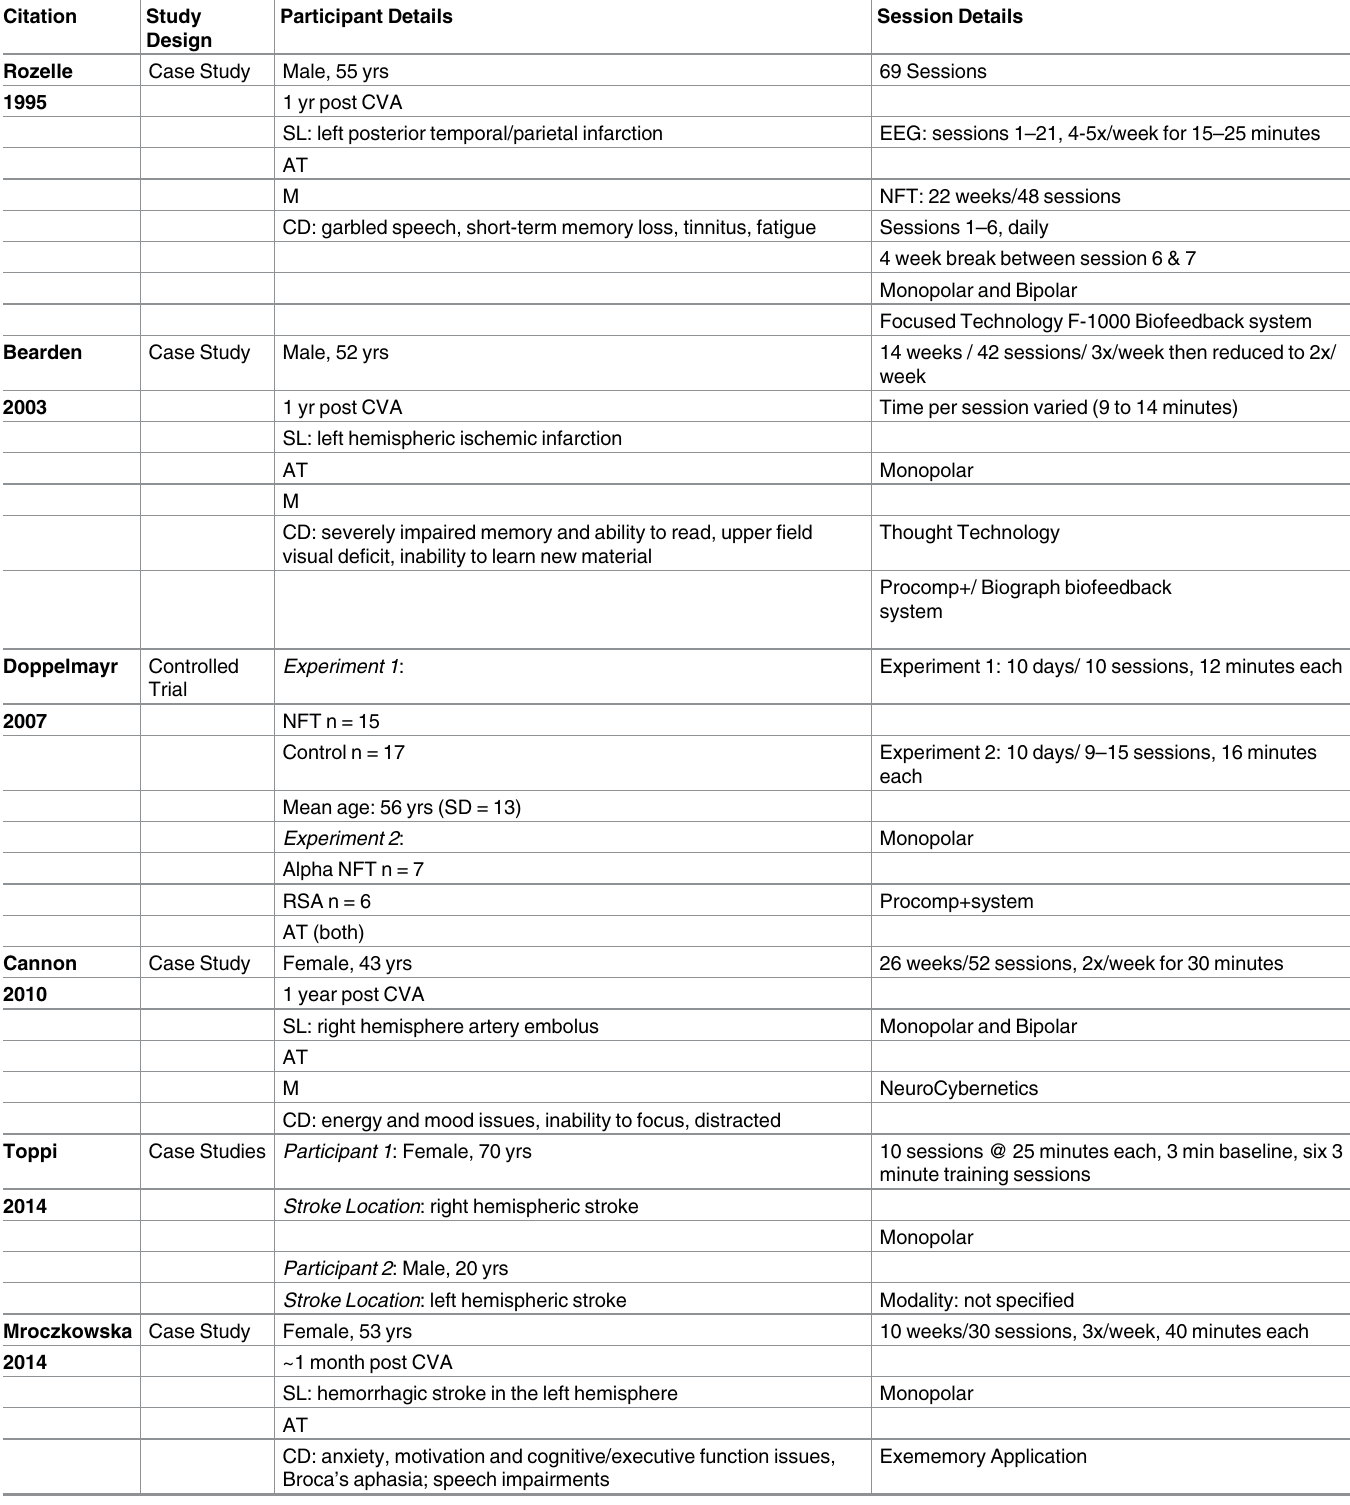
Table 1. Study design &